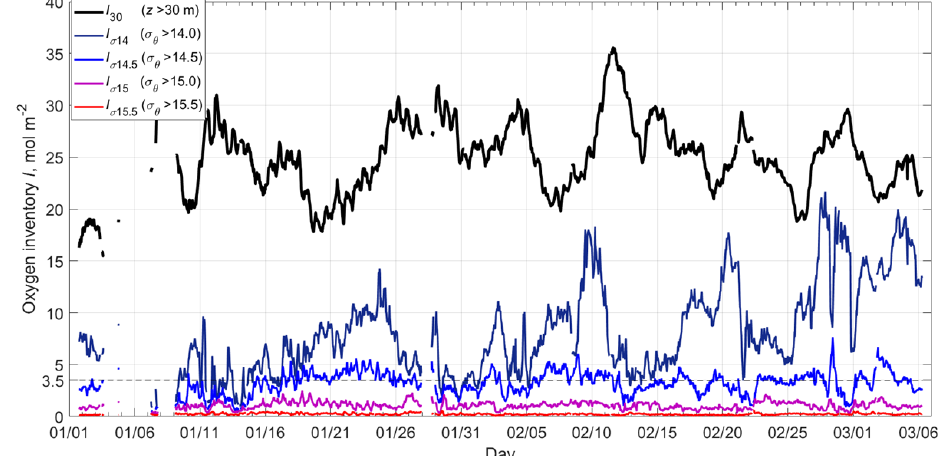
Figure 5. The oxygen inventory I per the Aqualog profiler data acquired from January to March 2016. The green line is the oxygen inventory I 30 below 30m in the sea. Other colored lines denote the oxygen inventories I σ 14 ,...,σ 15 . 5 in the layers below the respective isopycnal depths, as specified in the top left corner of the figure.